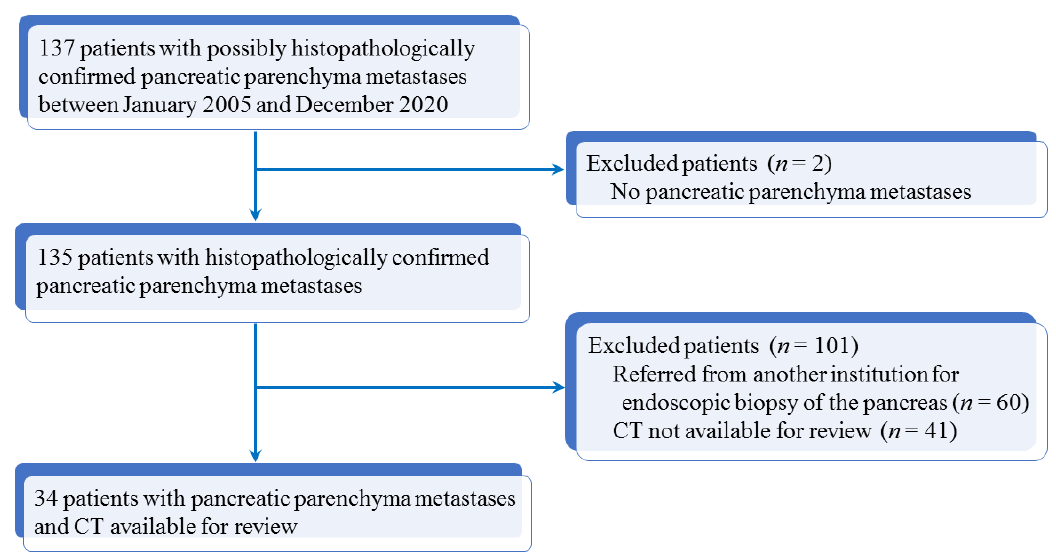
Figure 1. Flowchart shows study inclusion process of patients with pancreatic parenchyma metastases. Table 1. Demographics of 34 patients with metastasis to the pancreas and 34 patients with pancreatic ductal adenocarcinoma. The final study population consisted of 34 patients with PPM. There were 22 men and 12 women (mean age, 66.5 ± 10.7 [standard deviation (SD)] years; range: 40–82 years) (Table 1).